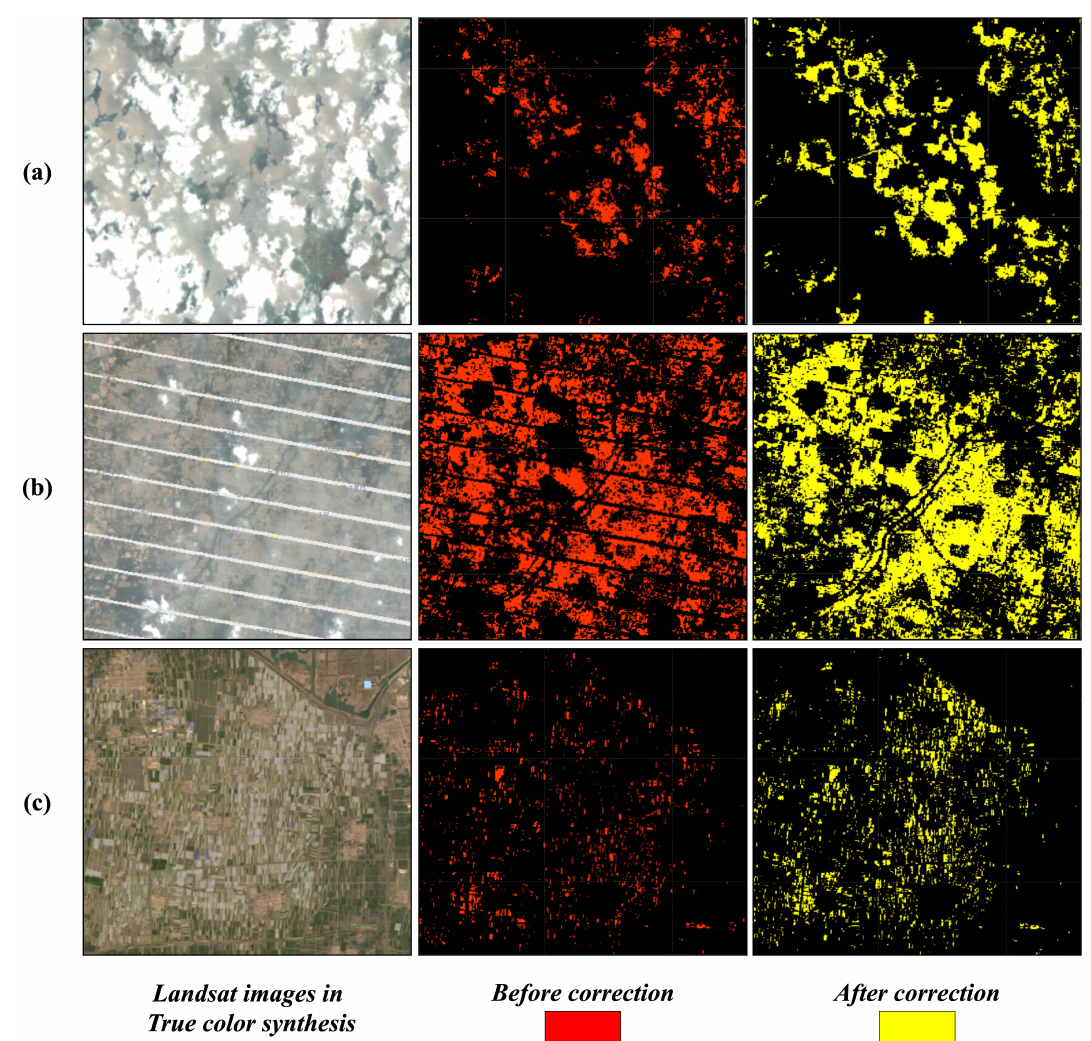
Figure 14. Improved classifications after implementing temporal consistency correction: ( a ) TM image acquired in 1996, ( b ) ETM image acquired in 2012; ( c ) OLI image acquired in 2018. Regions within ellipses are typical areas improved after implementing the proposed PTCC